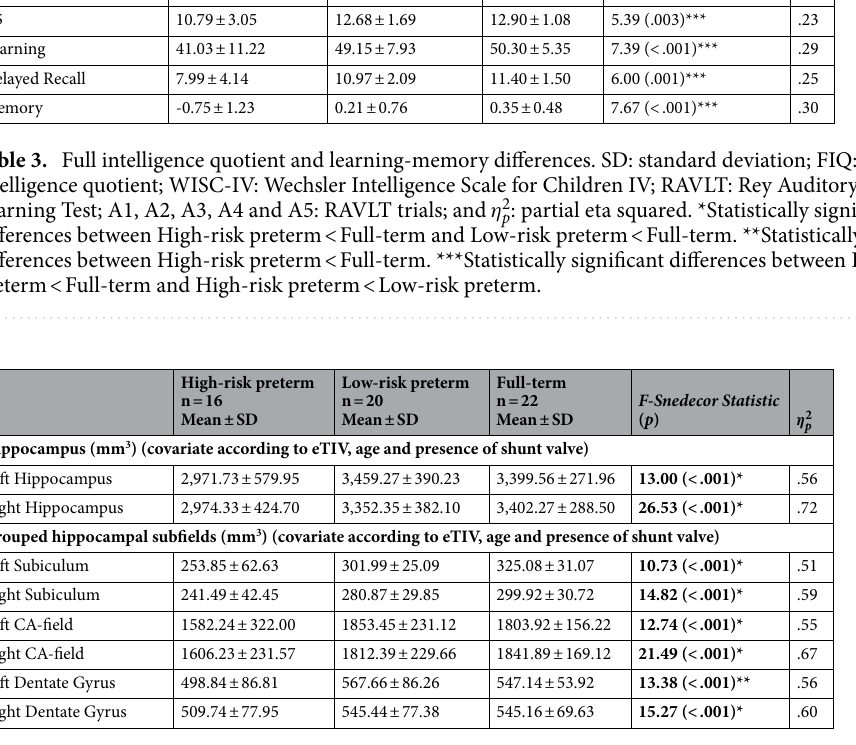
Table 4. Left/right hippocampus and grouped hippocampal subfield volumetric differences. SD: standard 2 deviation; mm 3 : cubic millimeter; and η p : partial eta squared. *Statistically significant differences between High-risk preterm < Full-term and High-risk preterm < Low-risk preterm. **Statistically significant differences between High-risk preterm < Low-risk preterm. The global bilateral hippocampal volumes and grouped hippocampal subfield volumes shown in bold are those that remained significant after Bonferroni correction was applied for multiple comparisons ( p = .006).